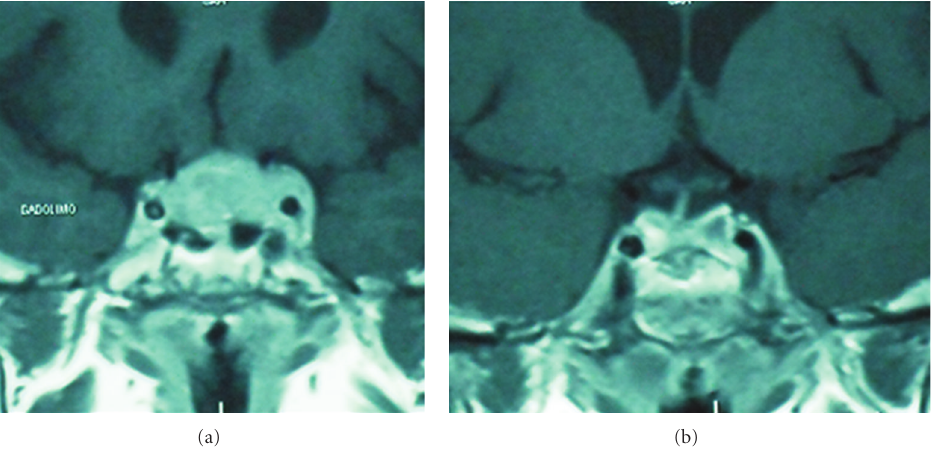
Figure 8: Enhanced MRI coronal view. In this case, the left CS was really invaded. Observe how the left carotid artery is completely surrounded by the tumor (a). Patient was operated on through a TS approach and fortunately, the tumor was soft and so, it could be removed, including the intracavernous portion (b). However, biochemical remission of the disease could not be